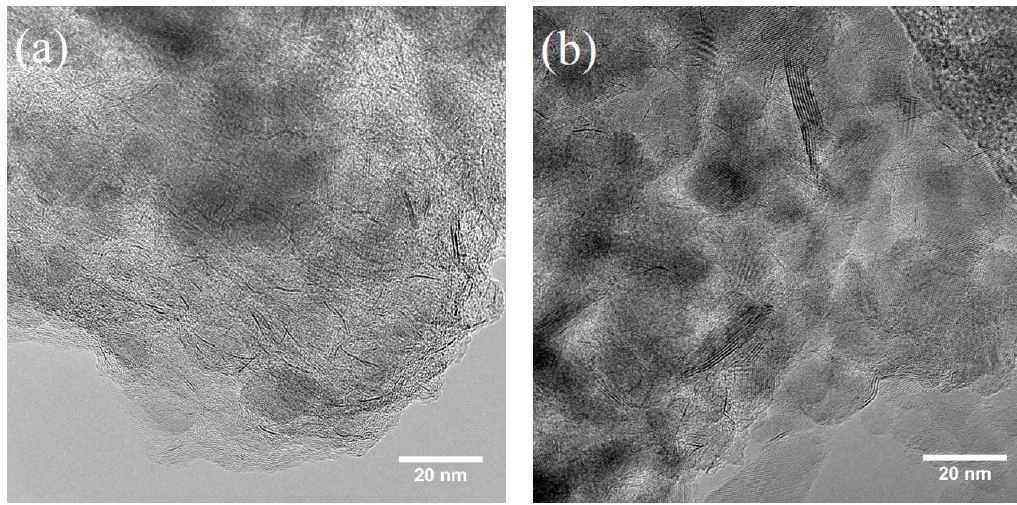
Figure 5. TEM images of the sulfided NiMo/MgAl 2 O 4 catalyst after the experiments: ( a ) EG; ( b ) Phe/EG-ReAct.